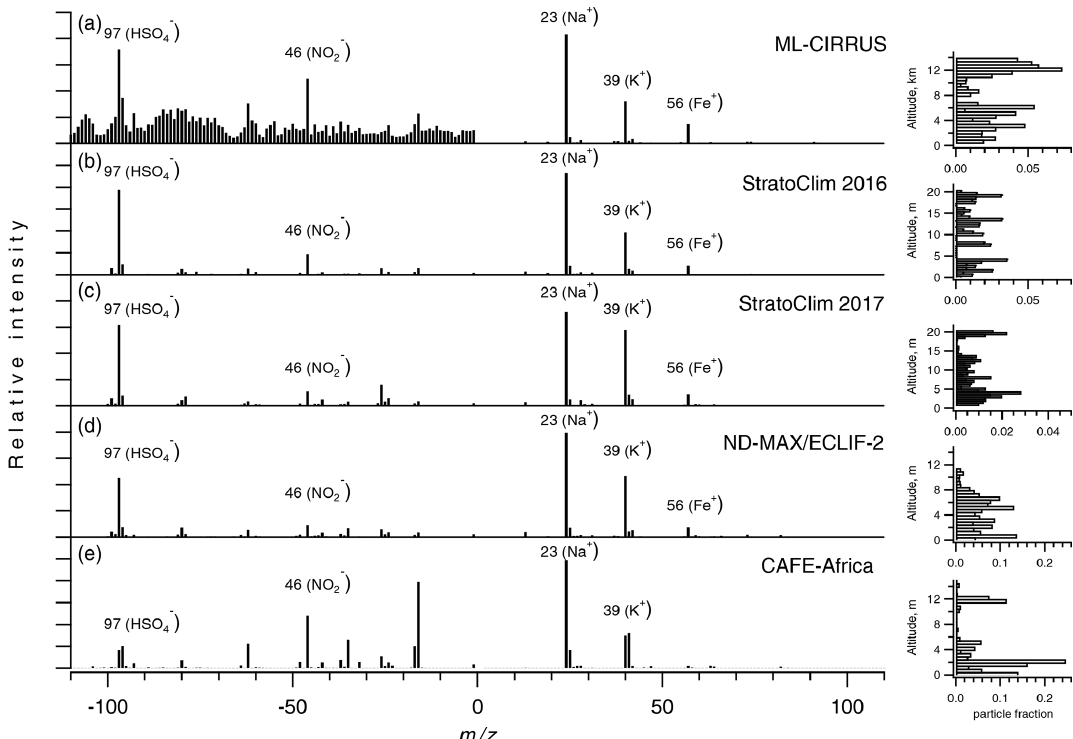
Figure 5. Mean mass spectra and vertical profiles of a particle type containing Na, K, and Fe, with smaller amounts of Mg and Ca. This type, which was observed in all five high-altitude aircraft missions, does not belong to the meteoric particles, although it was sometimes observed at higher altitudes. It can be interpreted as mineral dust, internally mixed with sea spray and secondary inorganic compounds (nitrate and sulfate). Note that during ML-CIRRUS the anion spectra were noisy due to problems with the high-voltage supply of the ALABAMA.